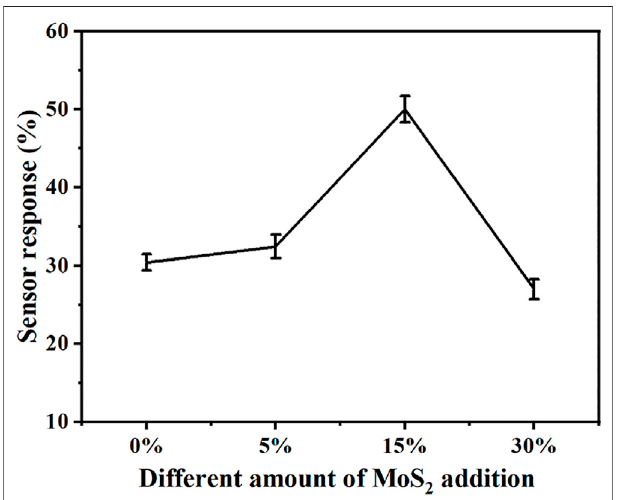
FIGURE 9 | Sensor response of the Cs x WO 3 /MoS 2 nanocomposite sensor with respect to amounts of MoS 2 added to Cs x WO 3 .